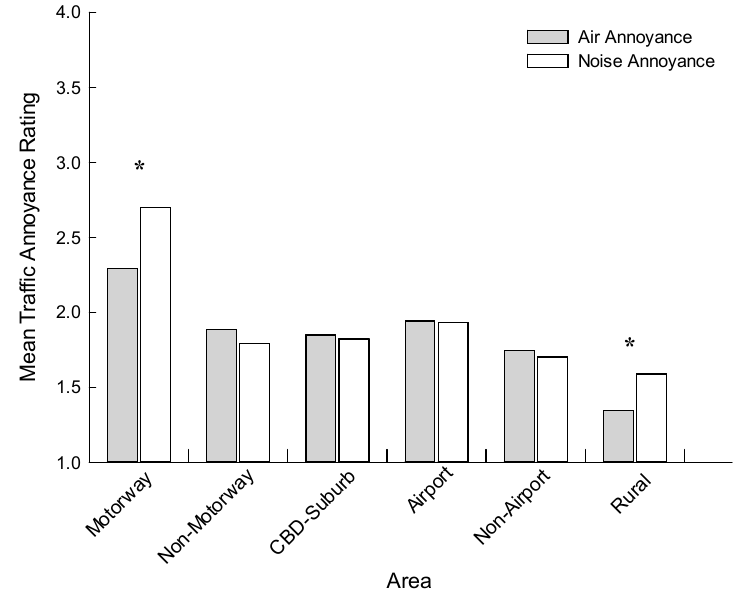
Figure 2. Mean air quality and noise annoyance ratings as a function of area. Asterisks indicate statistically significant differences ( p < 0.001) between air quality and noise annoyance ratings within an area.